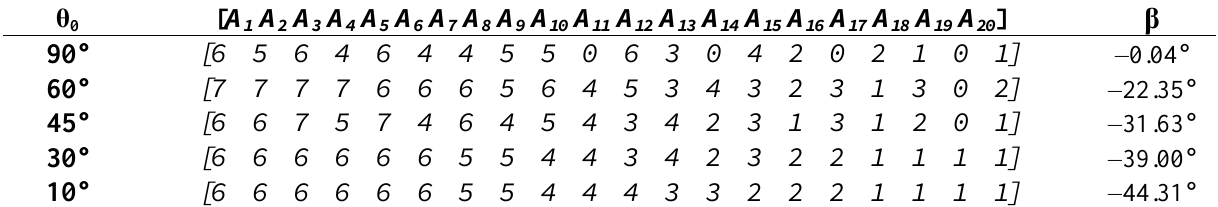
Table 2. Individuals with higher fitness in tests of the GA-MMC first application [13]. θ 0